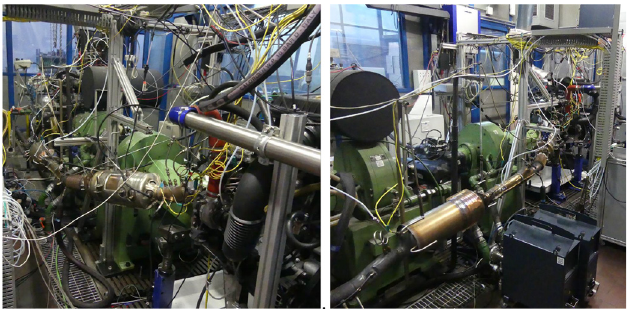
Fig. 9. Engine test bench and installation of the after-treatment system.